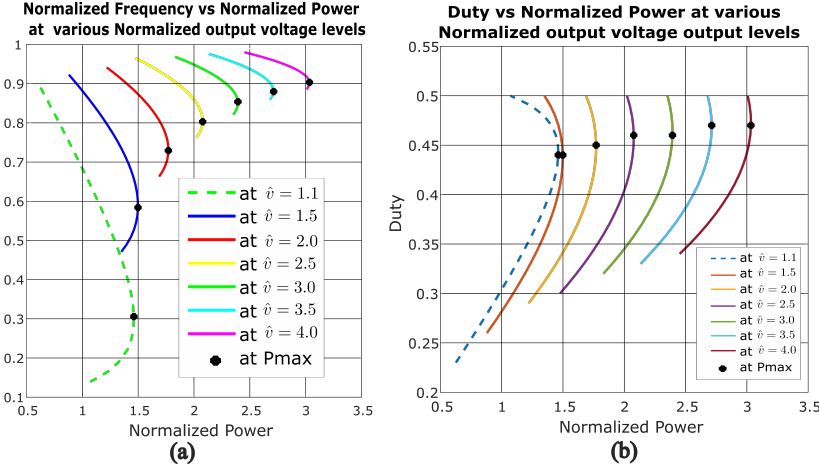
Figure 5. Graphical illustration where: ( a ) shows normalized Frequency vs normalized power, ( b ) shows duty vs normalized power. In presence of various level of normalized output voltage. Figure 5a indicates the normalized frequency as a function of the normalized output power, in presence of the normalized output voltage. Hence, the normalized frequency is a function of both the normalized output voltage and normalized output power. In Figure 5b, the duty as a function of normalized power, in presence of normalized voltage, is illustrated; it implies that the duty is a function of both the normalized output voltage and the normalized power. Figure 5 can be expressed using Equation